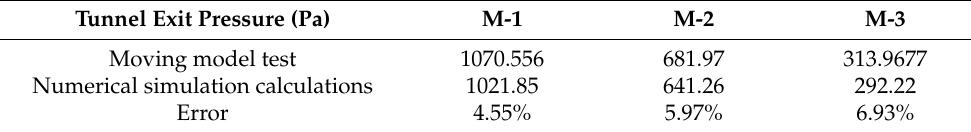
Table 2. Comparison of moving model test and numerical simulation